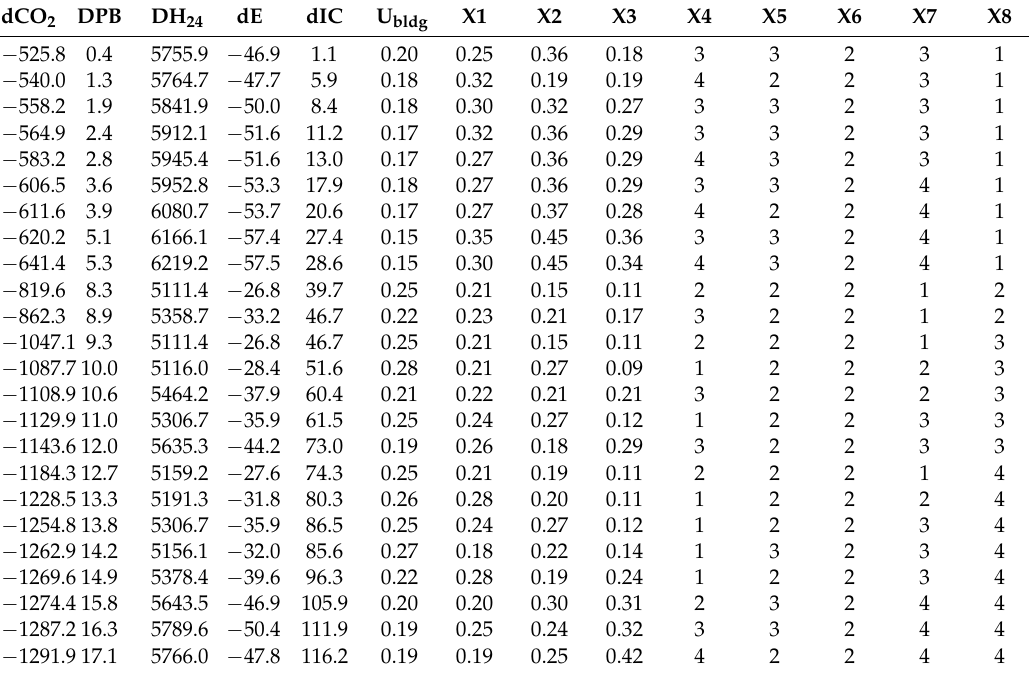
Table A1. Optimal Pareto solutions for Case 1 ( P 1).